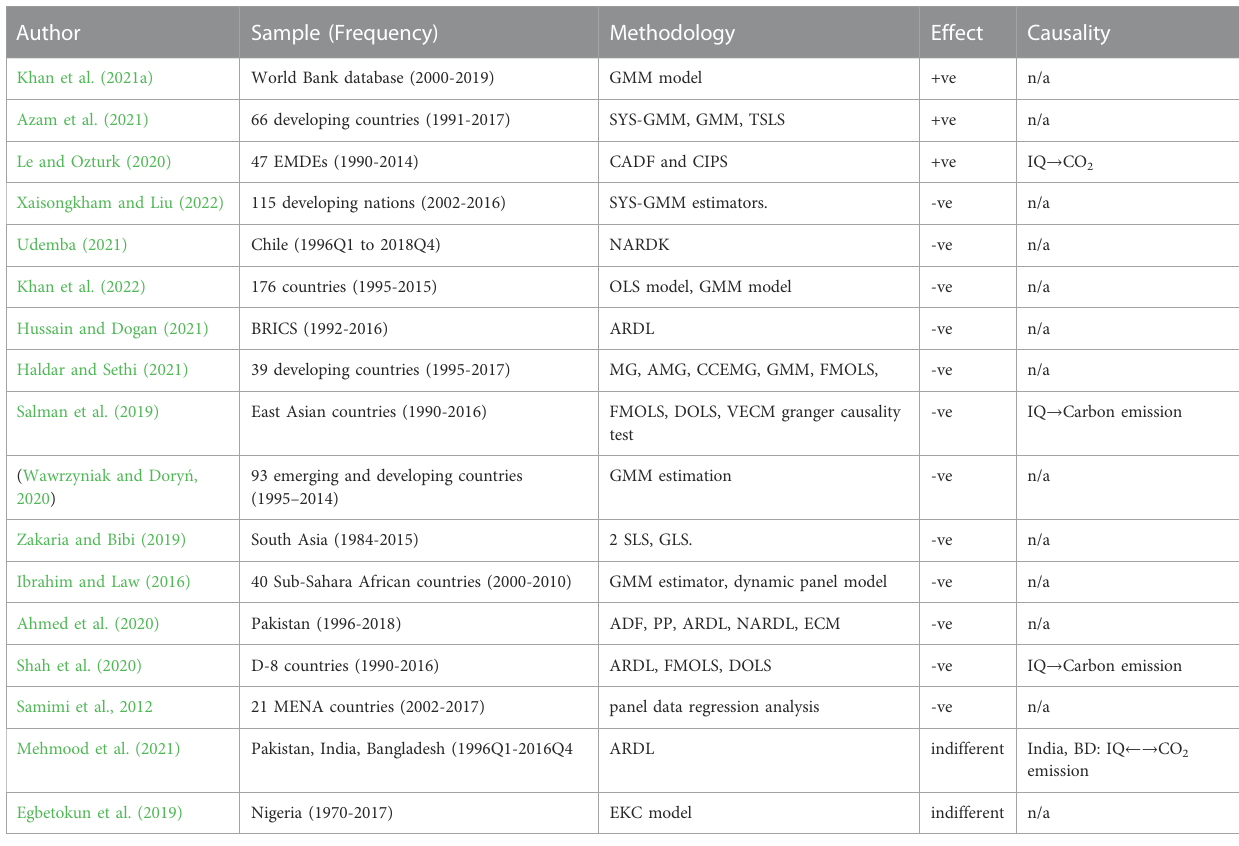
TABLE 3 Summary literature survey: IQ – led ED.